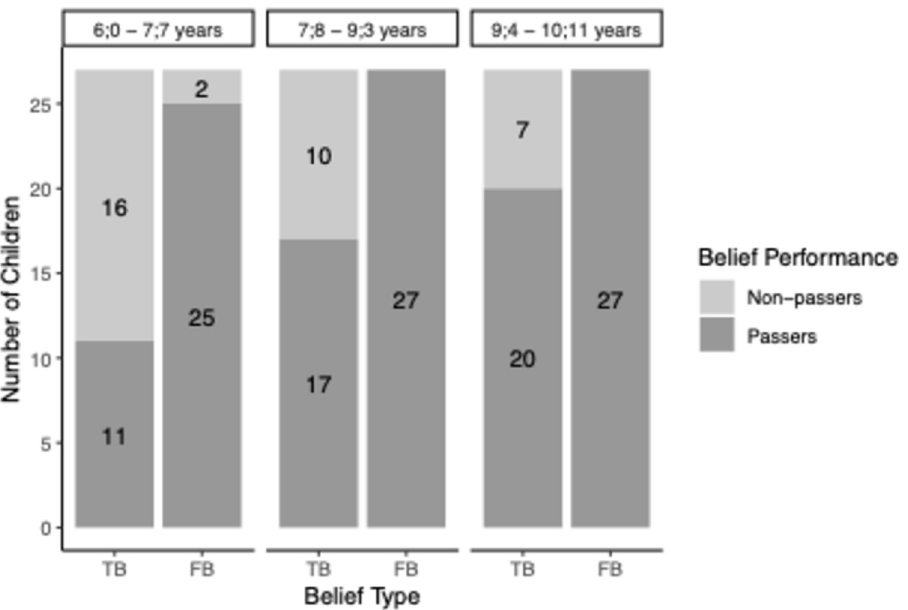
Fig 3. Children’s performances in the standard change-of-location task as a function of age group and belief type in Study 1.